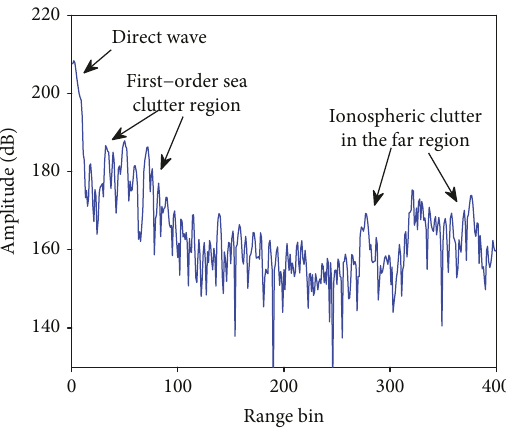
Figure 3: Range spectrum of the no. 130 Doppler